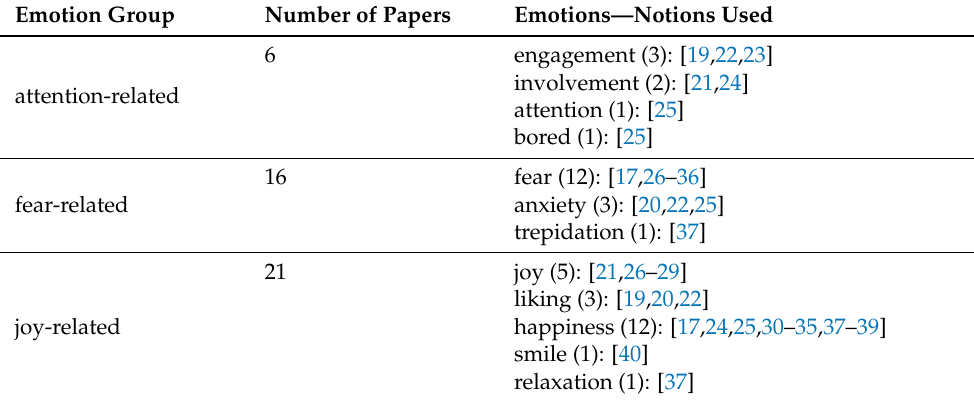
Table 2. Papers describing recognized emotions groups. Emotion Group Number of Papers Emotions—Notions Used